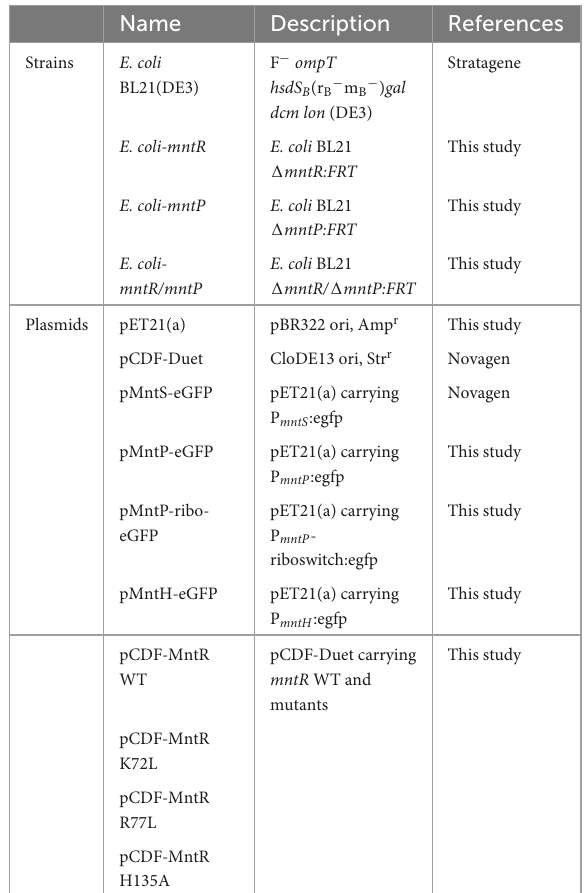
TABLE 1 The lists of Escherichia coli strains and plasmids used in this